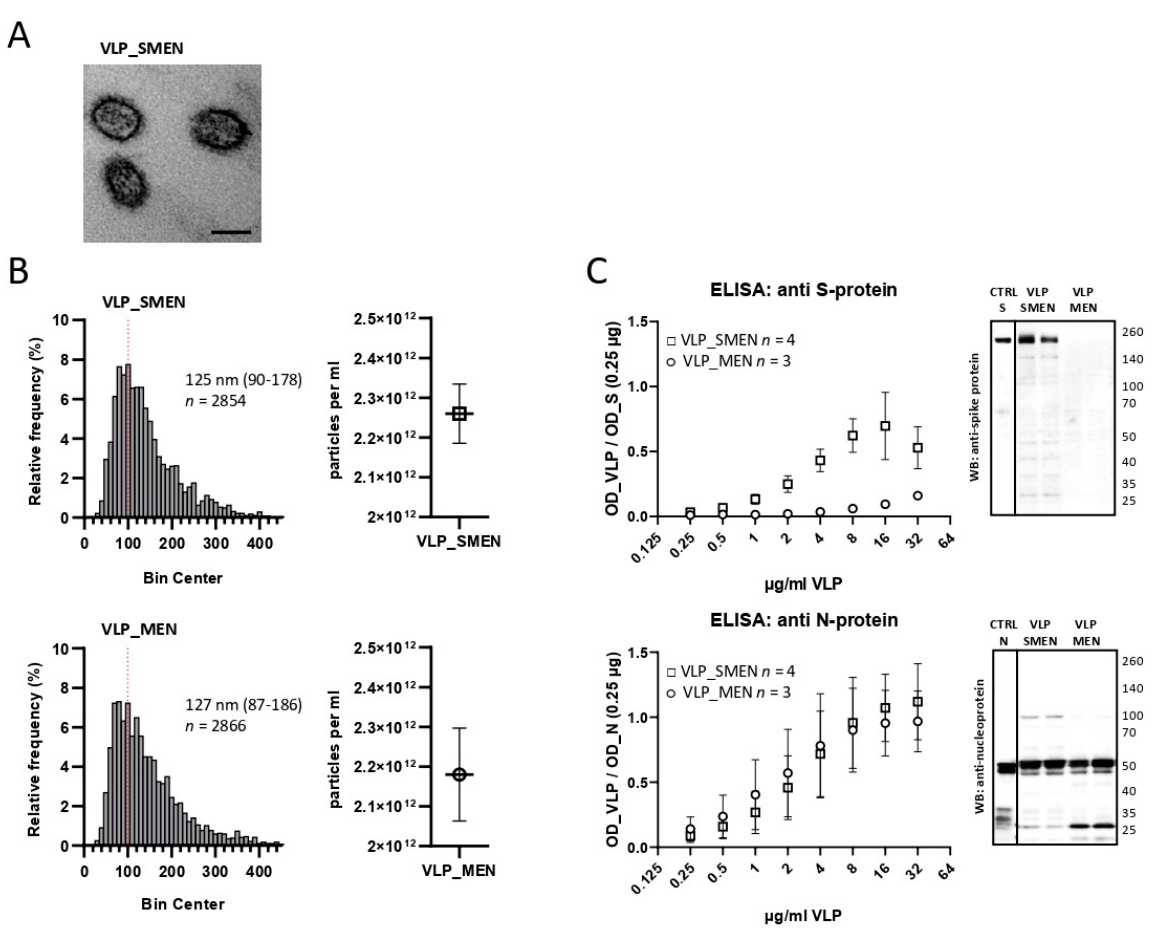
Figure 1. Characterization of VLP_SMEN and VLP_MEN. ( A ) Illustrative electron microscopy image of VLP_SMEN. Scale bar 100 nm ( B ) Nanoparticle Tracking Analysis (NTA). ( C ) ELISA using monoclonal antibodies against the spike or nucleoprotein and Western blot using a monoclonal antibody against the nucleoprotein and polyclonal human serum of a vaccinated individual.